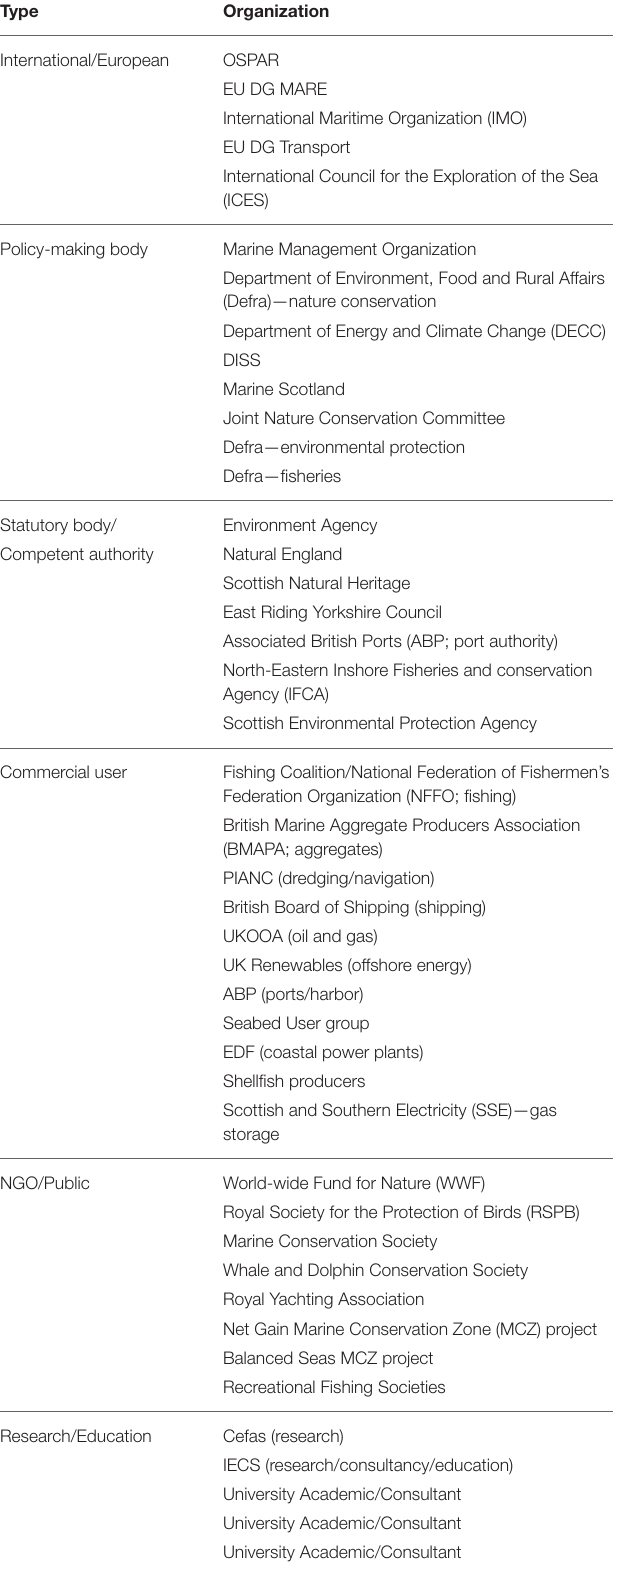
TABLE 4 | List of Marine Stakeholders—Example for the UK Sector of the North Sea (D Burdon, IECS University of Hull, pers. com).